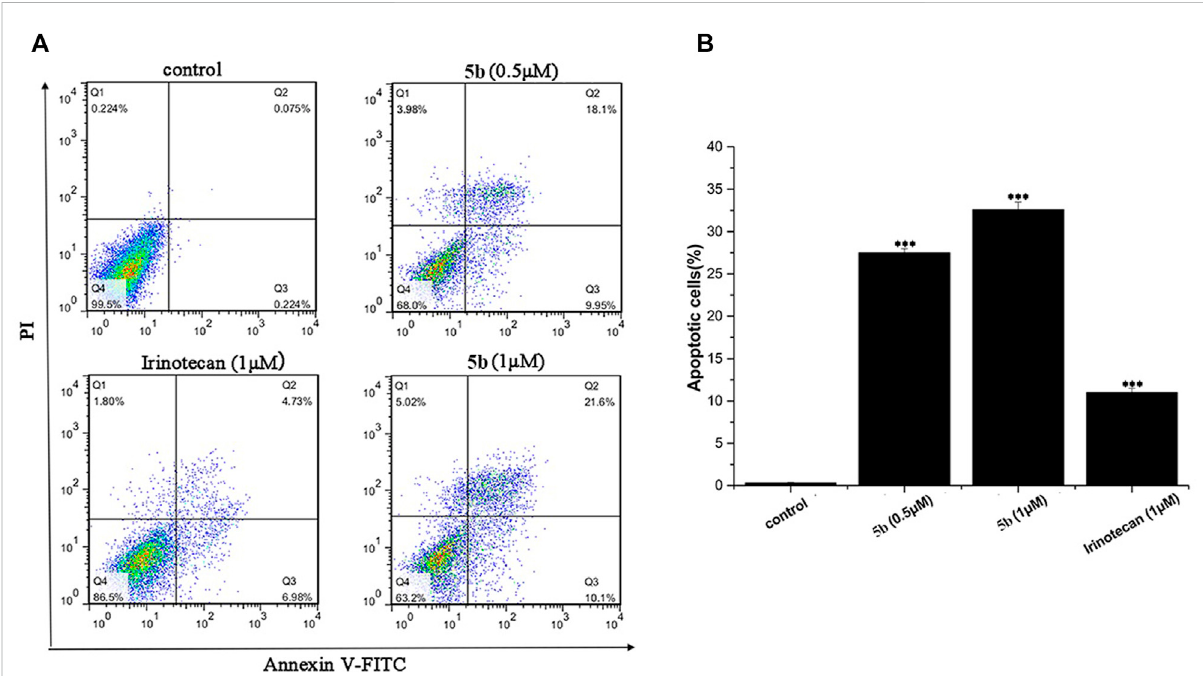
FIGURE 2 5b induced HCT116 cells apoptosis (A) The apoptosis rate of HCT116 cells treated by 5b and irinotecan. (B) Statistic results of apoptosis assays. Data are expressed as mean ± S.D. from three independent experiments (*** p <